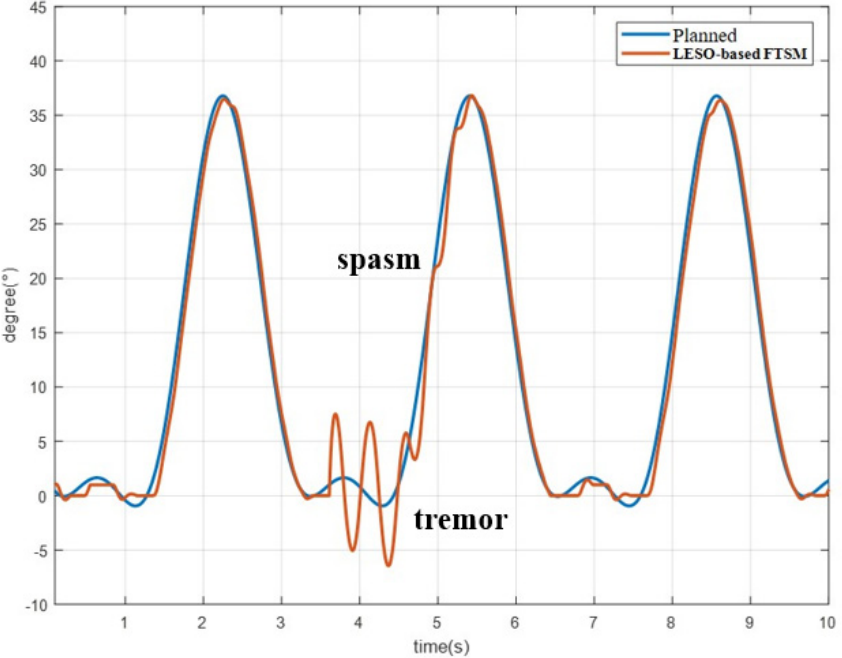
Figure 15. Trajectories of hip joint by LESO-based FTSM with spasm and tremor occurring at walking speed = 0.15 m/s.